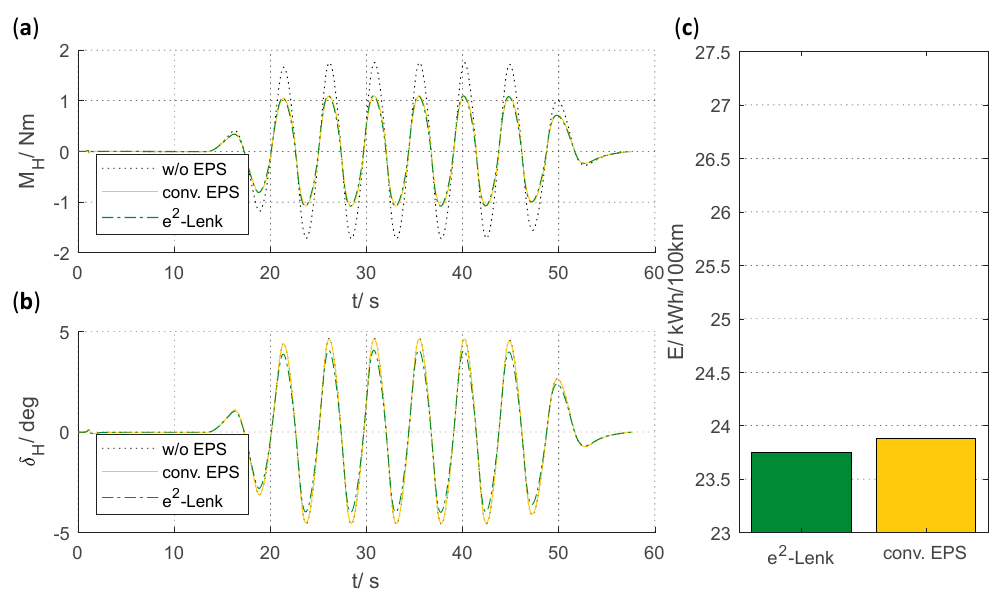
Figure 9. Slalom ‐ weave manoeuvre: ( a ) dynamic response of steering wheel torque, ( b ) dynamic response of steering wheel angle and ( c ) comparison of each suspension with a conventional EPS regarding energy.